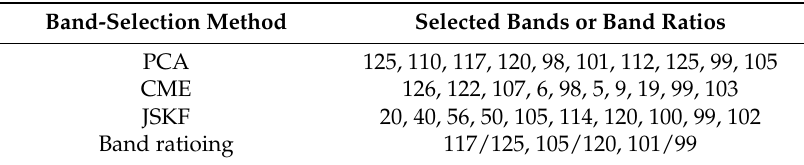
Table 2. Comparison of band indices selected by four methods at Stage I.